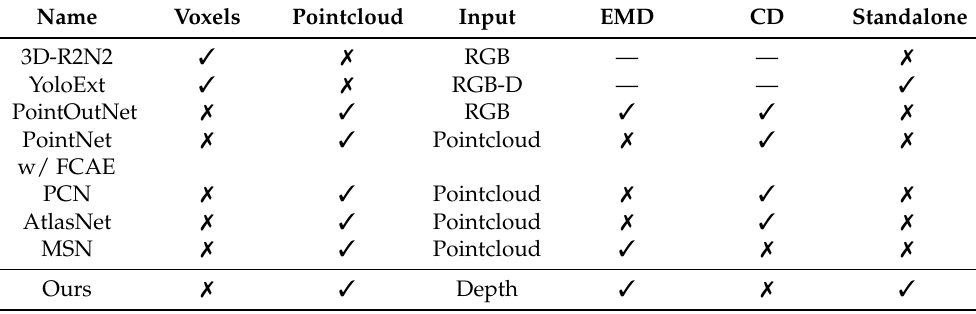
Table 1. Table comparing different existing implementations. Standalone refers to sensor-to-screen solutions where for any given sensor input a fully reconstructed model can be expected without inputting external information that the sensor itself cannot provide, such as masks.